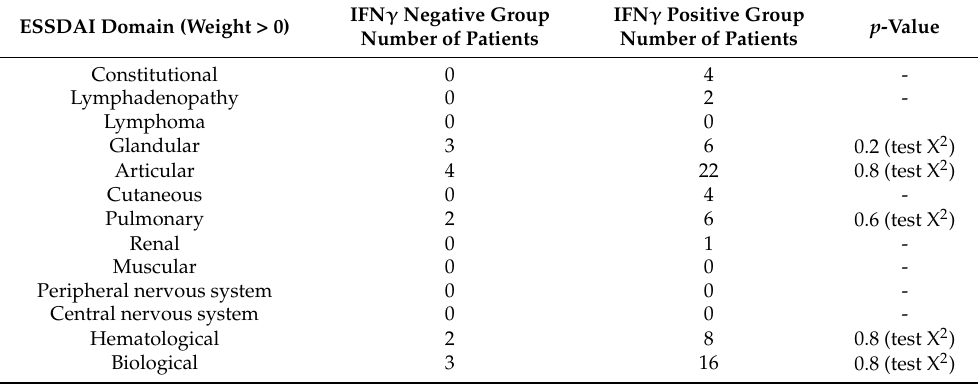
Table 2. The point value of individual ESSDAI domains in pSS patients with positive and negative IFN γ concentration in peripheral blood.